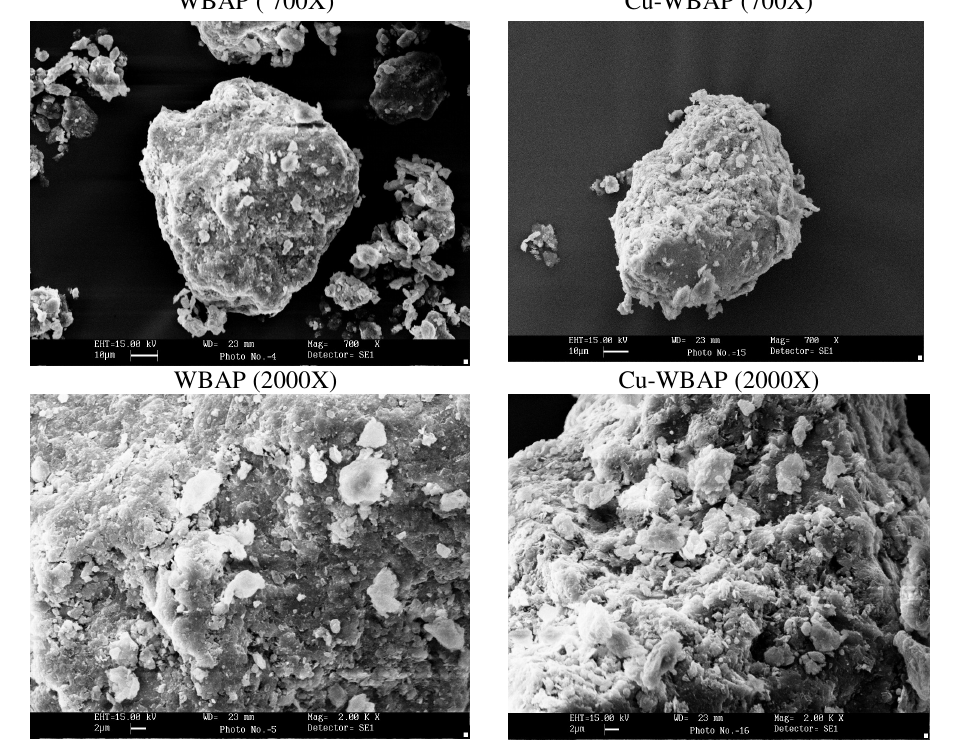
Figure 2. SEM photographs of WBAP and Cu sorbed